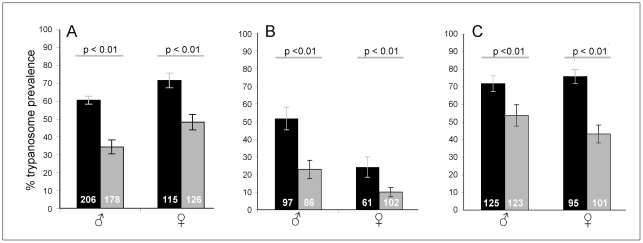
The relationship between trypanosome prevalence in the midgut and the age of the teneral fly.Male and female tsetse aged 24 h.p.e (black bars) and 48 h.p.e (grey bars) were offered a bloodmeal containing trypanosome parasites. Panel A shows the midgut infection prevalence of teneral G. m. morsitans infected upon the first bloodmeal with T. b. brucei TSW196 BSF; Panel B represents teneral G. p. palpalis infected with T. b. brucei TSW196 BSF; Panel C corresponds to teneral G. m. morsitans infected with T. congolense 1/148 BSF. The white numbers within the bars indicate the total number of flies dissected from three replicate experiments.